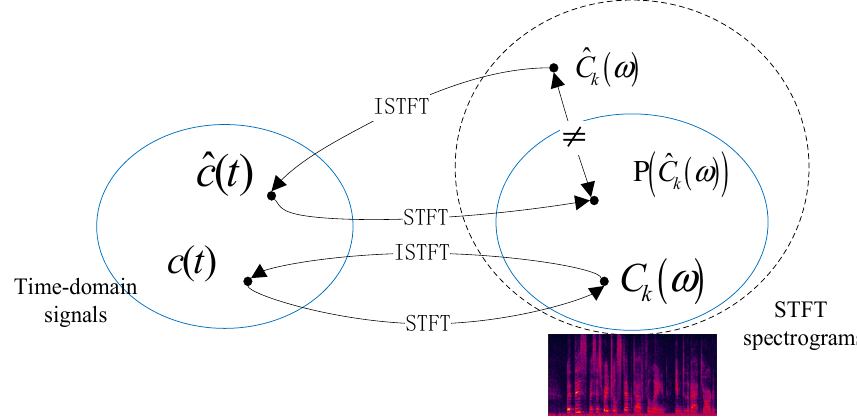
Figure 7. Schematic diagram of the inconsistency.